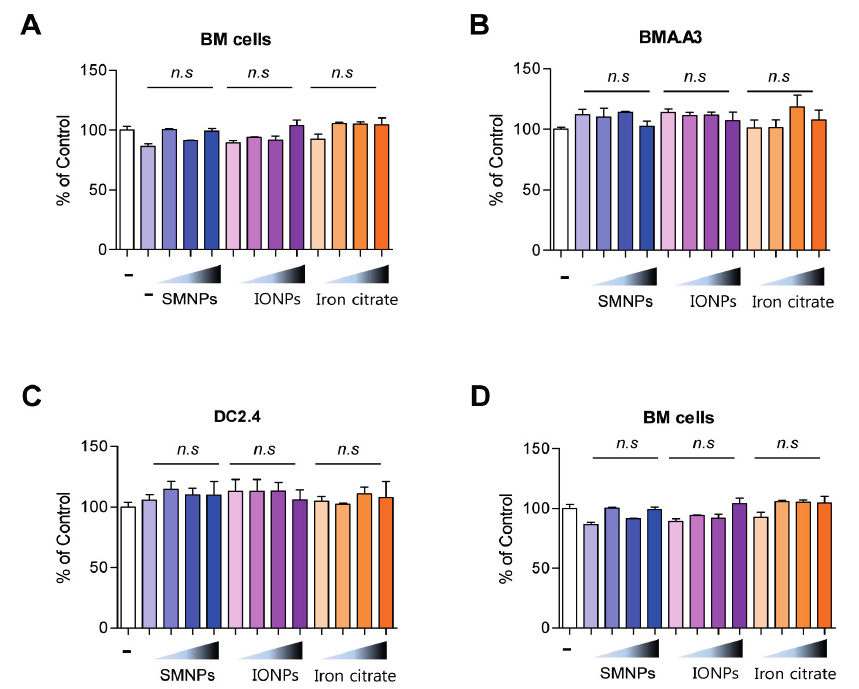
Figure 5. Cytotoxicity of surface-modified nanoparticles (SMNPs), iron oxide nanoparticles (IONPs), and iron citrate to DC2.4, BMA.A3, A549, and mouse bone marrow cells. Mouse bone marrow cells ( A ); BMA.A3 ( B ); DC2.4 ( C ); and A549 cells ( D ) were plated in